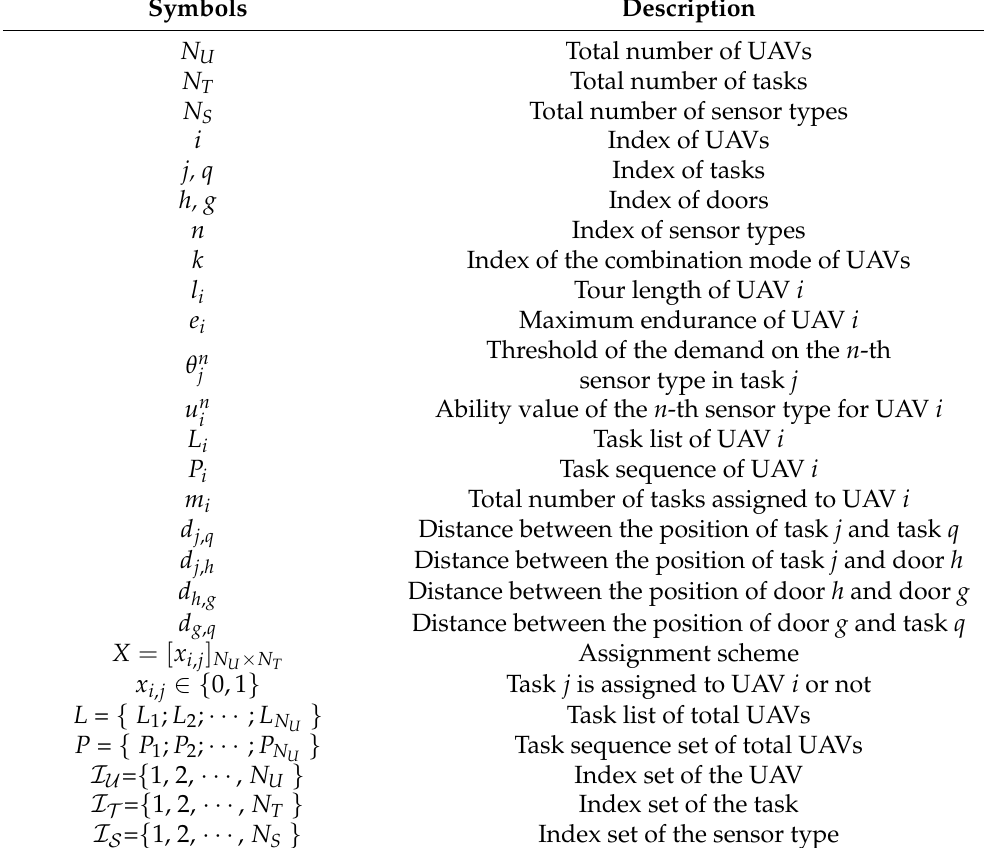
Table 1. List of parameters and variables.